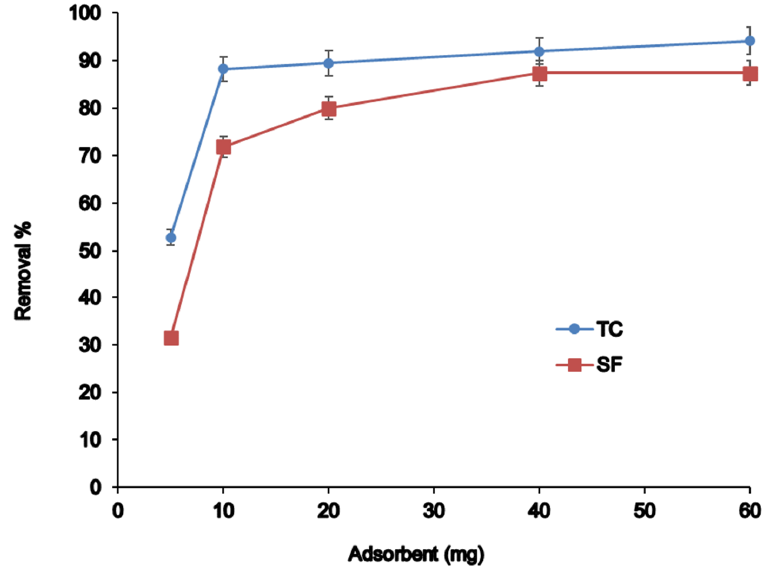
Figure 5. The effect of different amounts of adsorbent dosage.